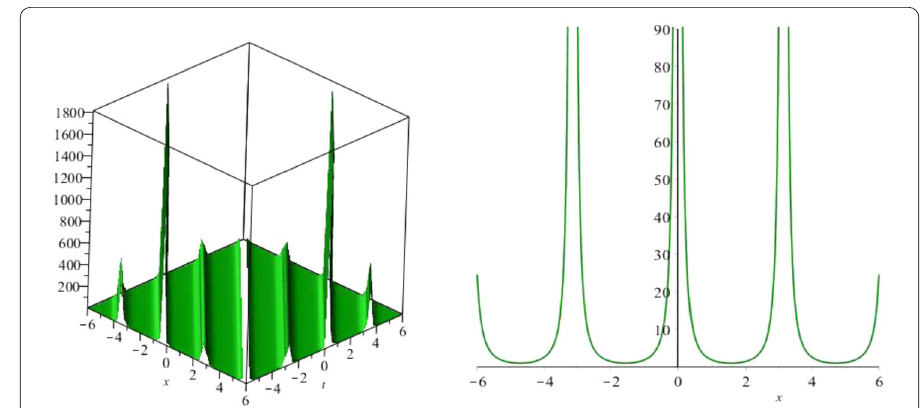
Figure 5 3D plot for φ 20 at y = 1 with A 2 = k = δ = 1 and 2D at t = 0